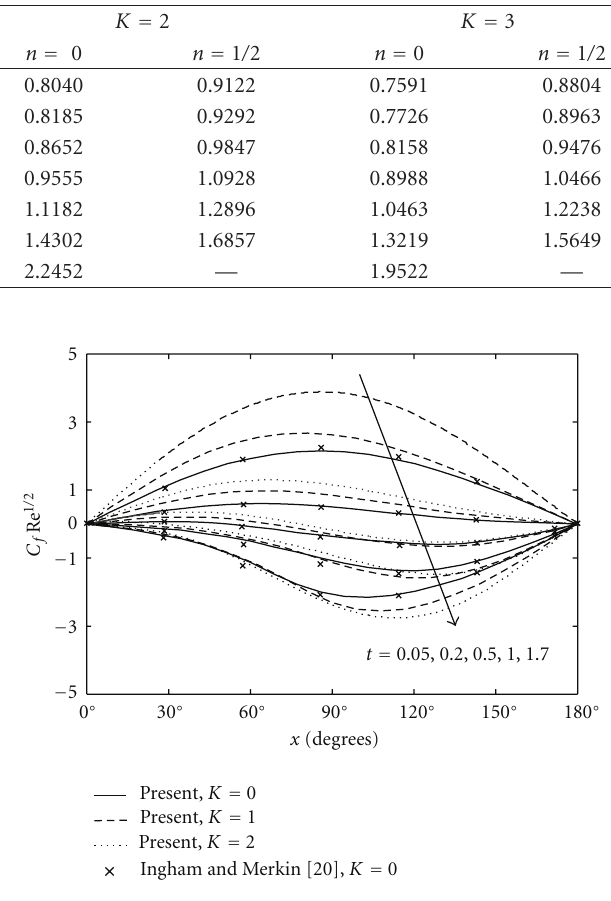
Figure 4: Variation of the skin friction coe ffi cient with x for K = 0, 1 and 2 with various values of t when Pr = 1, α = − 3 (opposing flow) and n = 0.